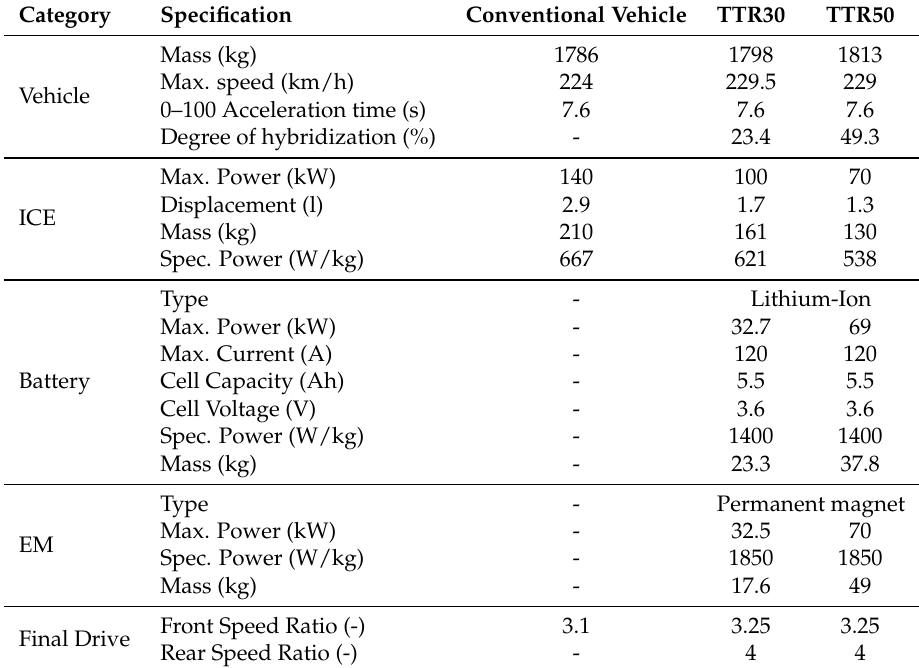
Table 3. Specifications of ICEs, EMs and batteries obtained from the Optminal Layout Tool